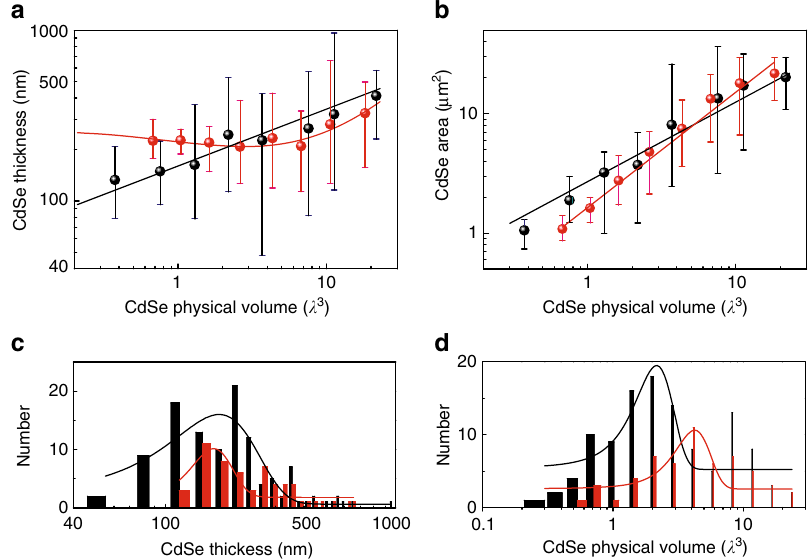
Fig. 3 Scaling laws of physical volume vs. thickness. a The relationship between T and V for only the lasing plasmonic and photonic cavities, where T and V are the thickness and volume of cadmium selenide nanosquares, respectively. The relationship between T and V for the plasmonic nanolasers (black dots) follows the natural scaling law of T / V 1 = 3 determined by the material growth process (black line). However, for photonic devices, the scaling of T shifts signi fi cantly away from the natural material scaling law when T approaches the diffraction limit (red dots). The red line is a guide to the eye. Error bar shows the thickness range for a certain number of measured devices with the same volume. b The relationship between cadmium selenide area A and V for only the lasing plasmonic (black dots) and photonic cavities (red dots), where A is the area of cadmium selenide nanosquares. Black line: guide to the eye of A / V 2 = 3 . Red line: guide to the eye of A / V . Error bar shows the area range for a certain number of measured devices with the same volume. c Cadmium selenide thickness distribution histogram for plasmonic (black columns) and photonic (red columns) lasers. Lines: Gaussian distribution fi ttings. d Cadmium selenide physical volume distribution histogram for plasmonic (black columns) and photonic (red columns) lasers. Lines: Gaussian distribution fi ttings. In all the panels, λ refers to 700 Figure 2a shows the lasing spectrum of a typical plasmonic spontaneous emission lifetime of the gain material, which helps to nanolaser with height of 140 nm, length of 2 μ m, and width of 1.6 μ m (inset: AFM image). The device shows pronounced single mode laser emission with a linewidth of 0.7 nm at 698 nm. The normalized spectra of the device vs. the pump power, shown in Fig. 2b, indicates a clear transition from spontaneous emission to lasing emission evidenced by the linewidth narrowing effect. The laser behavior is also evidenced by the “ S ” shaped light – light curve in log scale as shown in Fig. 2c where the lasing threshold is − 2 . The spontaneous emission read to be about 32 kW cm coupling factor ( β factor) of the device is obtained to be about 0.09 from a fi tting of the light – light curve using rate equation. Fig. 5. We note that the devices are optically pumped by a nanosecond pump laser with pulse width comparable to the